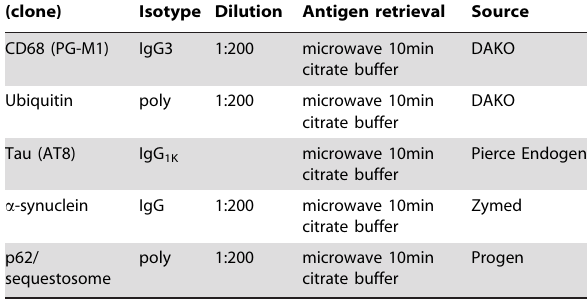
Table 1. Antibody source and conditions.